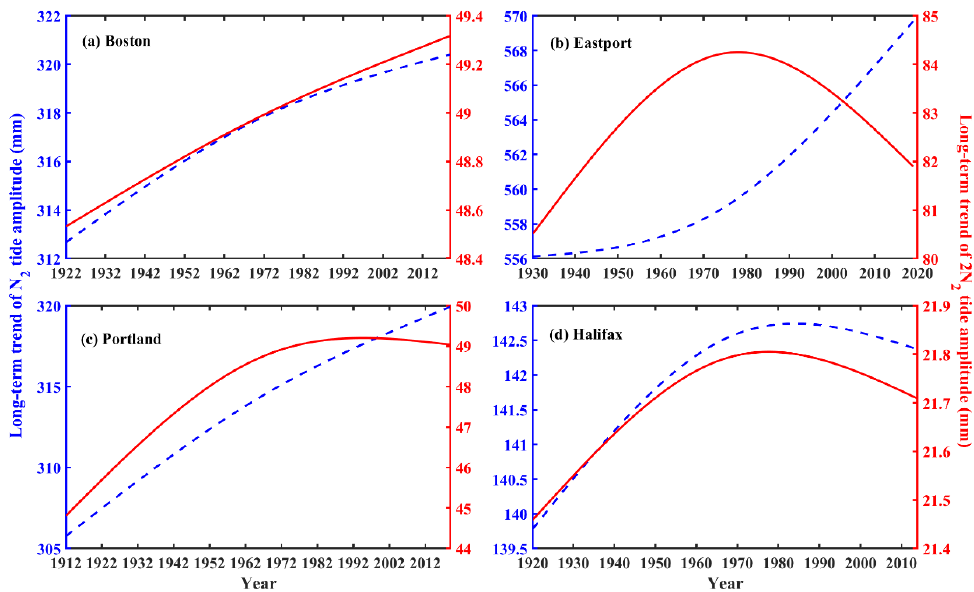
Figure 5. The long-term nonlinear trend of the N 2 (blue dash line) and 2N 2 (red solid line) tidal amplitudes at four stations.